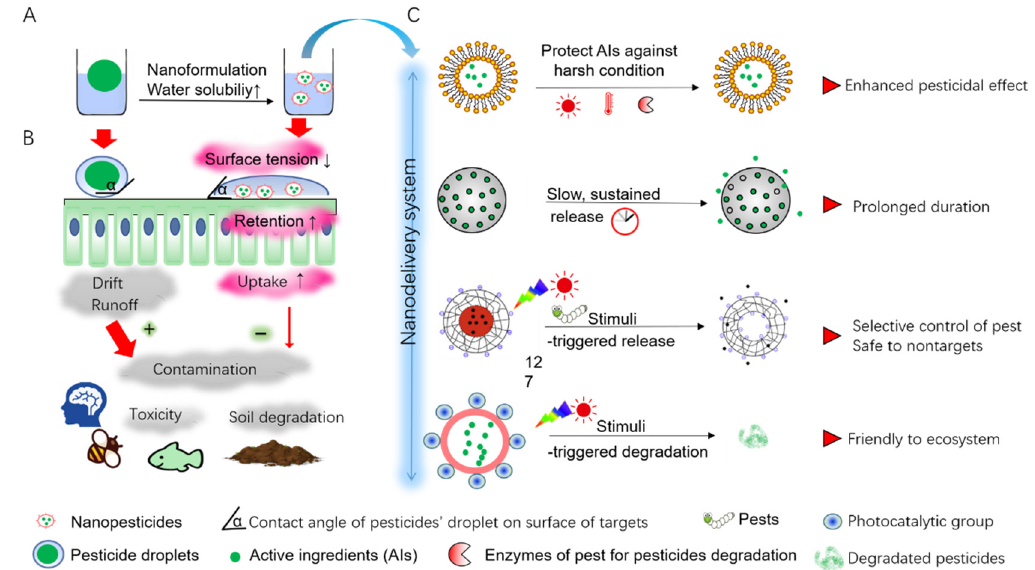
Figure 1. The benefits of nanotechnology for pest control. ( A ) Nanoformulation increase water solubility and stability of pesticidal active ingredients (AIs) by encapsulating AIs into small NCs-based pesticides that are conferring excellent characteristics at nanoscale. ( B ) Nanoformulation reduces surface tension of pesticidal droplets by decreasing the contact angle of droplets on the surface of targets (crop foliage), which contributes to a prolonged retention of droplets and a subsequently increase uptake ratio by target cells. This will be conducive to reduce the contamination caused by pesticides drift or runoff, bringing less toxicity to nontargets (mammal, pollinator, and aquatic organism) and bypassing yield reduction arising from the soil degradation. ( C ) Various nanodelivery systems that play a role in sustainable and smart application of pesticides.